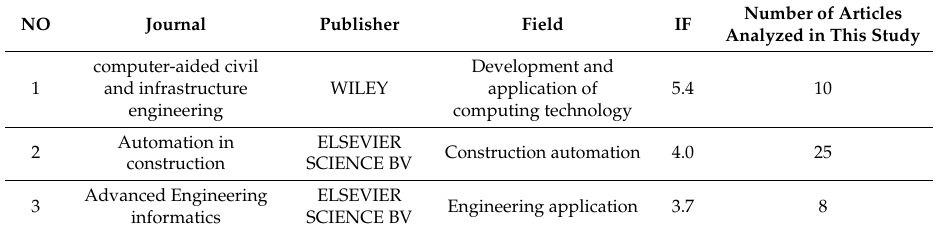
Table 1. Journal information and number of articles analyzed in this